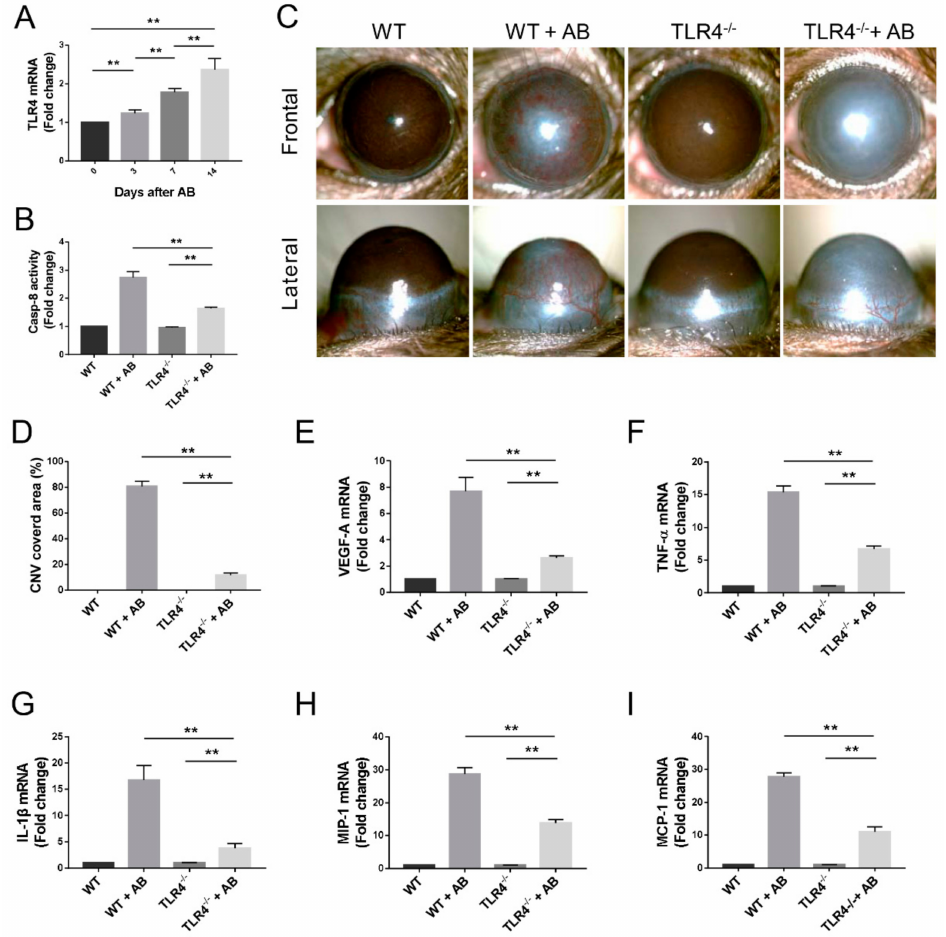
Figure 7. Caspase-8 activity is partially regulated by TLR4 signaling. ( A ) RT-qPCR analysis of TLR4 mRNA expression in corneas of WT mice at various time-points ( n = 3). ( B ) Colorimetric assay of caspase-8 activity in corneas ( n = 3). ( C ) Representative images of the macroscopic CNV appearance on WT and TLR4 - / - mice on day 14 after corneal AB injury. ( D ) Statistical analysis of the CNV covered area of WT and TLR4 - / - mice ( n = 6). ( E – I ) RT-qPCR analysis of VEGF-A, TNF- α , IL-1 β , MIP-1, and MCP-1 mRNA expression in corneas ( n = 3). The data are presented as the mean ± SD. ** p <